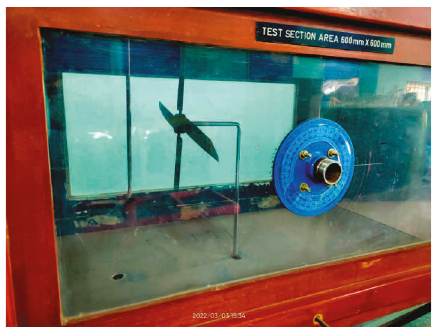
Figure 8: NASA SC(2)-0714 rotor model in the wind tunnel. Table 3: Result of HH02 rotor.